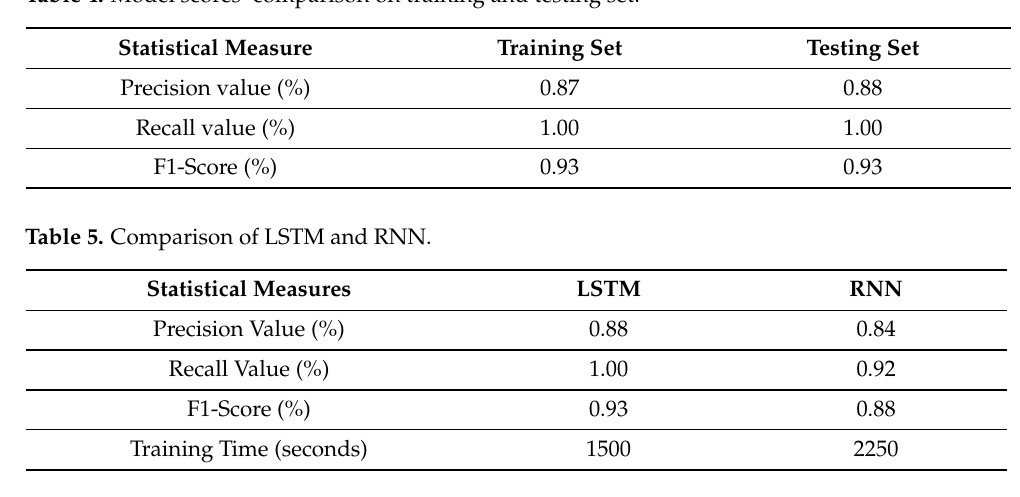
Table 4. Model scores’ comparison on training and testing set.